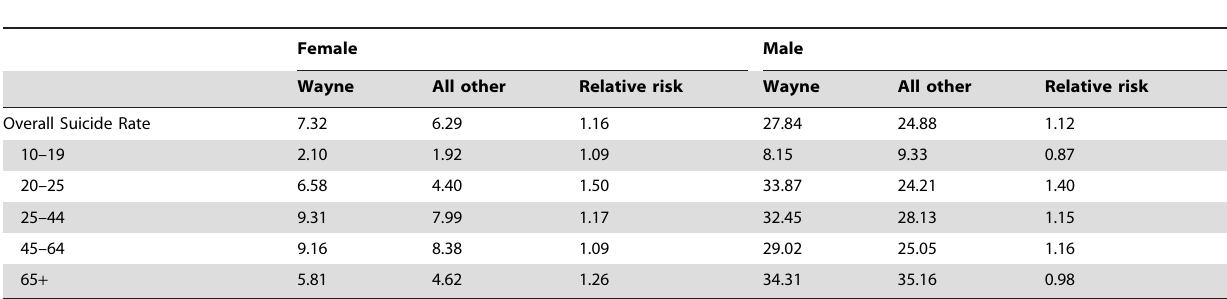
Table 4. Age-adjusted suicide rates (per 100,000 per year) inside and outside of Wayne county as well as relative risk of suicide in Wayne county relative to all other counties among non-ethnic white males and females aged 10 and older in Michigan,